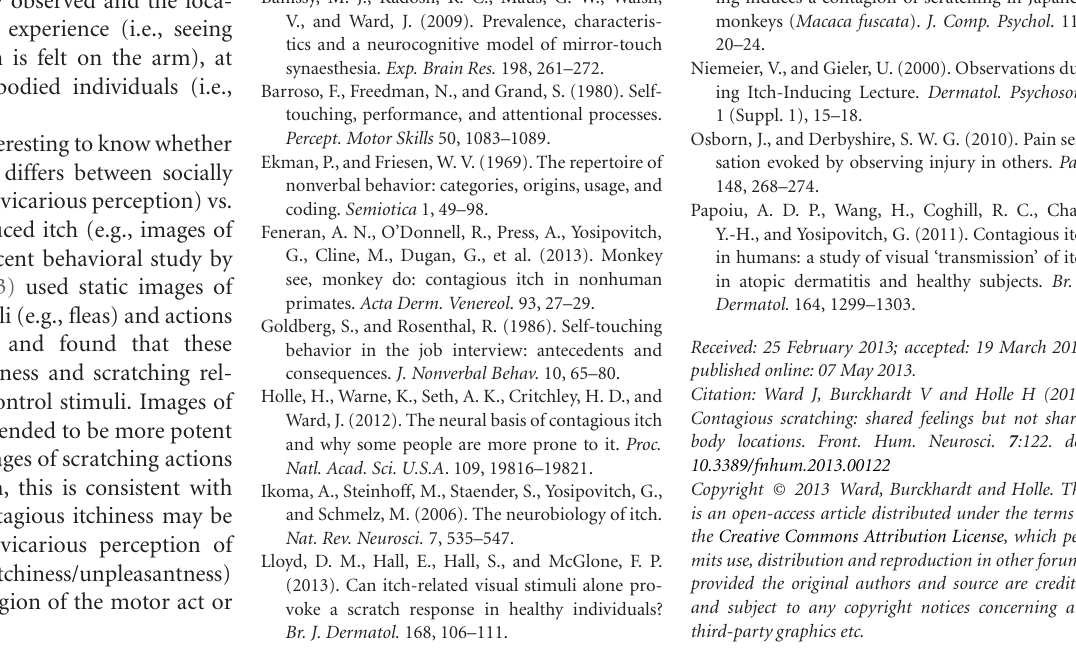
cases, there is a direct